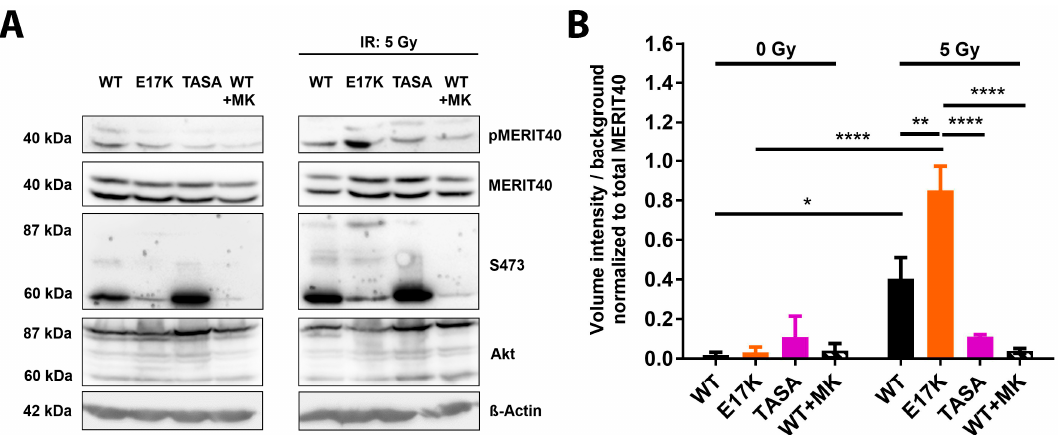
Figure 5. The Akt’s activation state impacts the phosphorylation of the HRR-associated Akt-target protein MERIT40. ( A ) TrC1 stably expressing the constitutively active Akt1-E17K, phosphorylation-deficient Akt1-TASA or Akt1-WT were exposed to irradiation with 5 Gy. Akt1-WT expressing TrC1 were additionally treated with 4 µM of MK-2206 2 h prior to IR. Phosphorylation status (S473) of the Akt1 mutants, as well as the expression and phosphorylation status of the assumed Akt-target protein MERIT40, at 0.5 h after irradiation depicted by western blot analysis. For S473 and Akt: lower bands (60 kDa) show endogenous Akt and upper bands (87 kDa) depict eGFP-fused Akt1-mutants. ( B ) The quantification of pMERIT40 western blots of 3 independent experiments shows volume intensity normalized to the background. Volume intensity of phosphorylated Akt was normalized to the volume intensity of the total amount of Akt. Bars represent means ± SD from 3 independent experiments. * p < 0.05, ** p < 0.01, **** p < 0.0001; ANOVA test with Tukey correction.